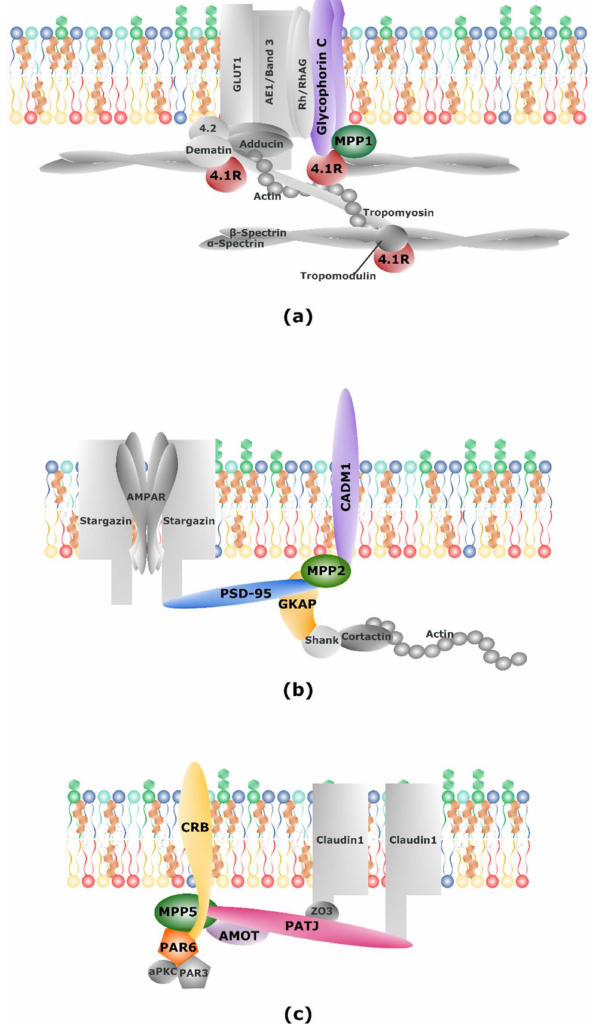
Figure 2. MPPs in protein complexes. Schematic illustration of protein complexes formed by MPPs. ( a ) Sca ff olding ternary complex formed by MPP1, glycophorin C (GPC) and protein 4.1 found in erythrocyte membranes; ( b ) sca ff olding complex formed by MPP2, postsynaptic density protein 95 (PSD-95), guanylate kinase-associated protein (GKAP) and CADM1 found at neuronal postsynaptic membrane; ( c ) Crumbs polarity complex formed by MPP5, CRB and PATJ and partitioning defective (Par) complex formed by Par6, Par3 and atypical protein kinase C (aPKC) found in epithelial cells. See main text for